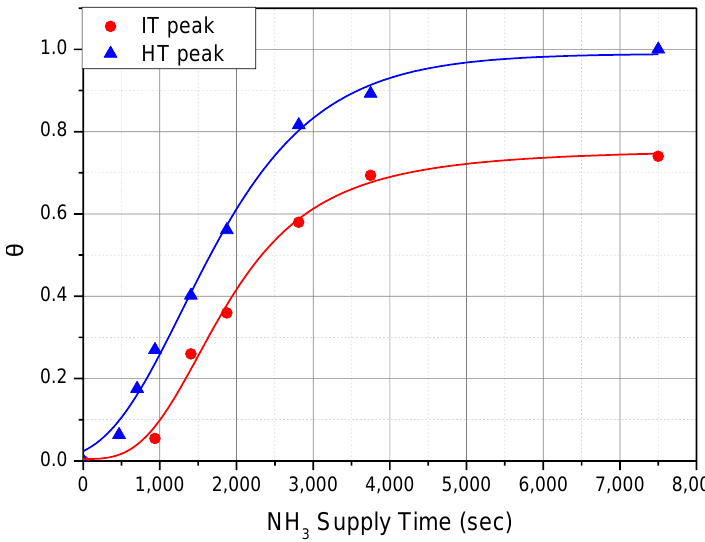
Figure 7. Change in θ of the HT and IT peaks according to NH 3 supply time (inlet NH 3 concentration: 200 ppm, temperature of NH 3 absorbing: 50 °C).